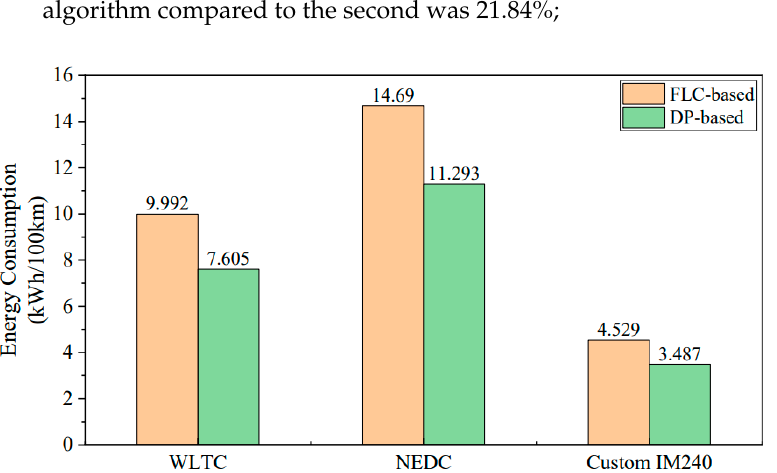
Figure 27. Energy consumption in three driving cycles using torque distribution based on FLC and DP during the experiment.